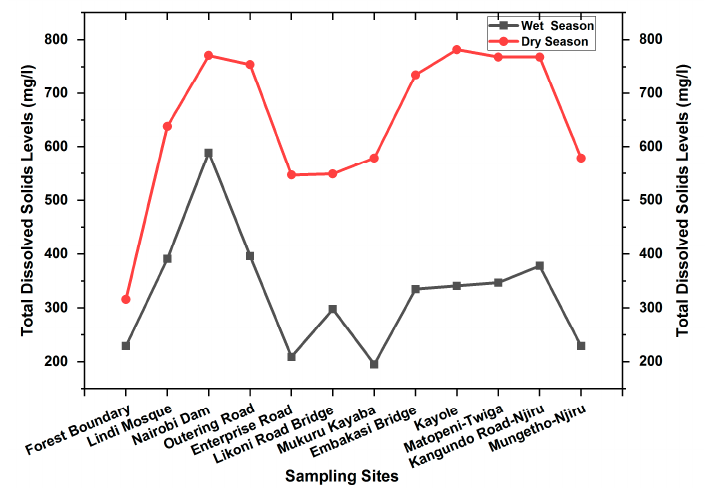
Figure 10. Total dissolved solids levels of Ngong